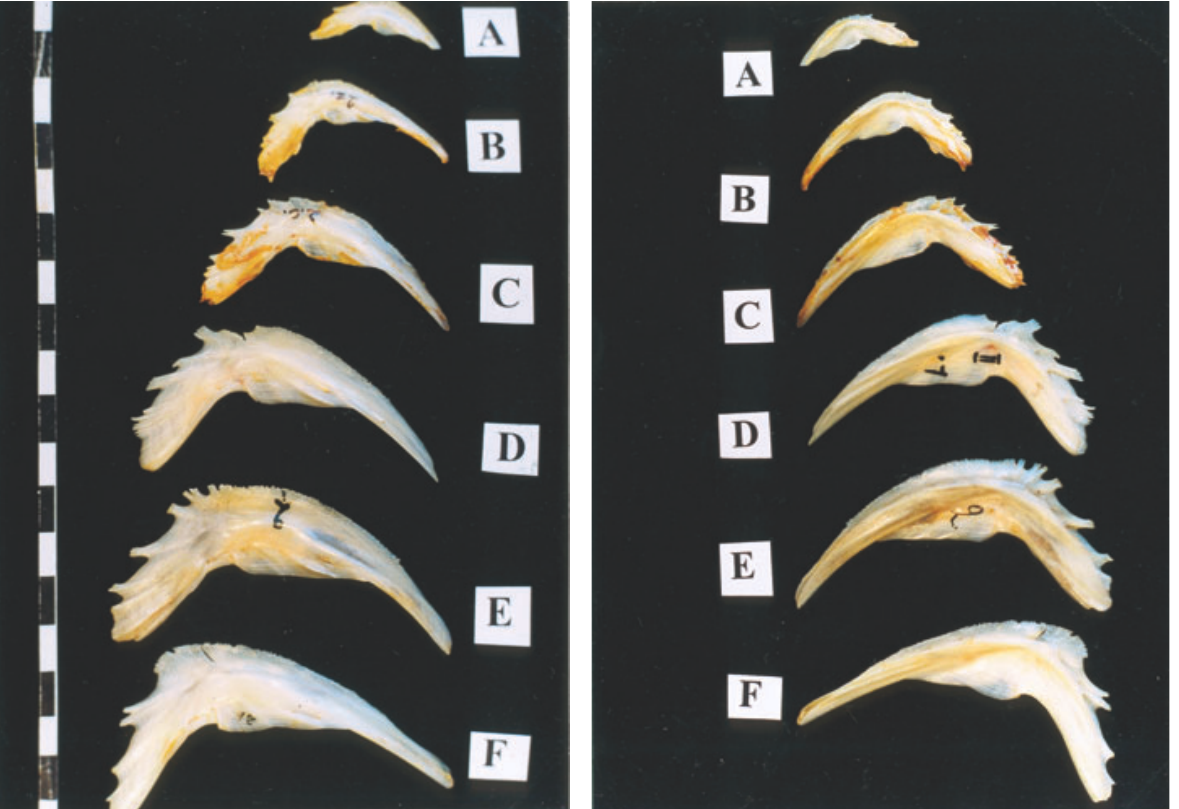
Fig. 2. Comparative materials: left preopercular bones of the zander, Sander lucioperca (L.), individuals weighing: A, 0.46 kg; B, 0.80 kg; C, 1.86 kg; D, 3.01 kg; E, 4.96 kg; F, 6.20 kg (outer- and inner